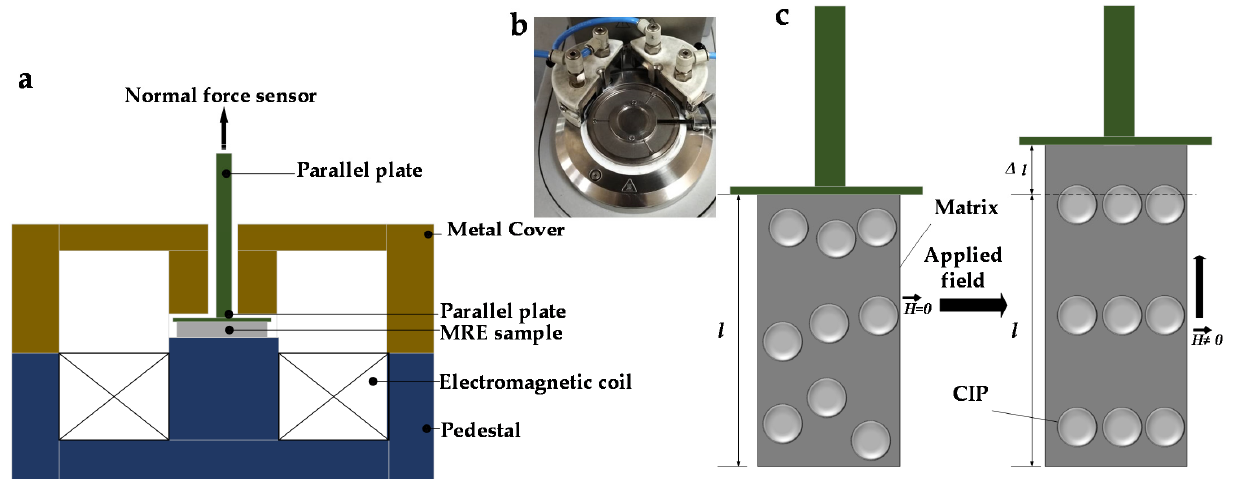
Figure 1. Experimental set ‐ up of magnetostriction measurement ( a ) Schematic illustration of rheometer, ( b ) the two ‐ part metal cover (MRD 170 controller) and ( c ) schematic illustration of the MRE under a magnetic field: H is the magnetic field intensity, l is the length of sample. Table 2. The current magnitude relative to the magnetic field. Current (A)